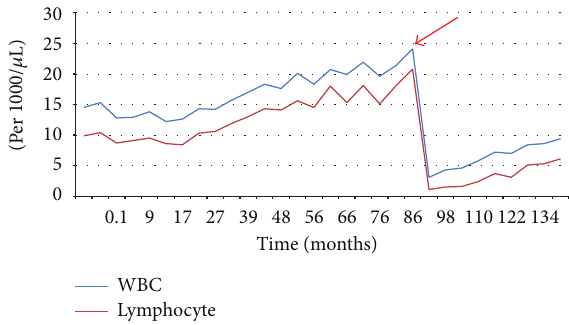
Figure 1: Pre- and postradioactive iodine therapy leukocyte and lymphocyte counts. The figure displays leukocyte and lymphocyte counts (per 𝜇 L) over 12-year (144 months) timeframe. Red arrow correlates to the initial dose of radioactive iodine therapy for papillary thyroid carcinoma and signifies the drop in leukocyte count from 24,100/ 𝜇 L to 3,100/ 𝜇 L and in lymphocyte count from 18,100/ 𝜇 L to 1,100/ 𝜇